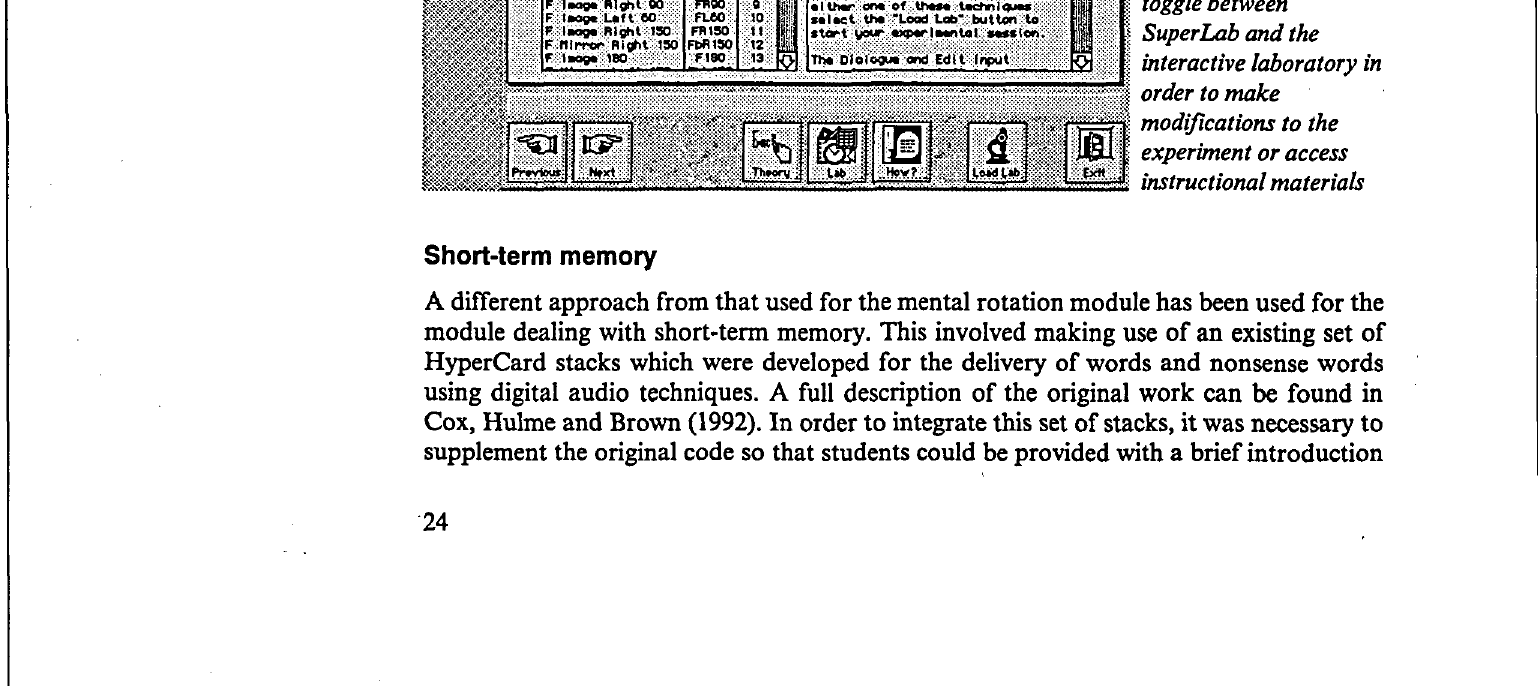
Figure 3: Users can toggle between SuperLab and the interactive laboratory in order to make modifications to the experiment or access instructional